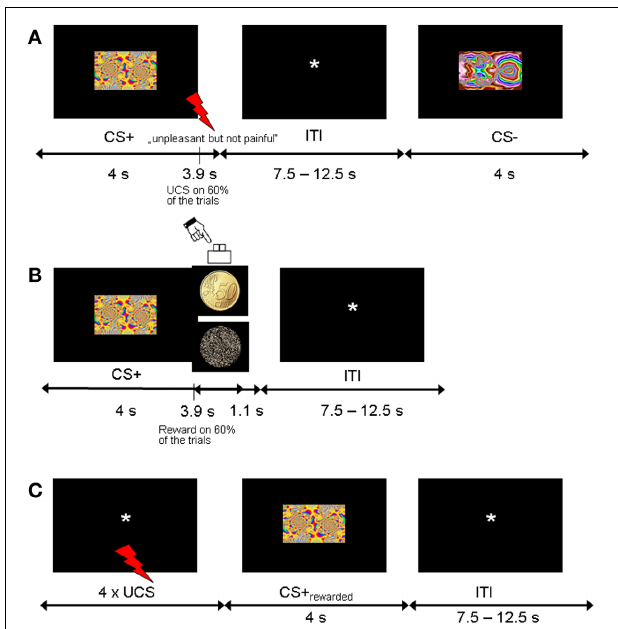
FIGURE 1 | Experimental design. (A) Trial sequence for the fear acquisition phase. CS + were followed by the shock UCS in 60% of trials. (B) Trial sequence for the counterconditioning phase. Half of the CS + and CS − stimuli from the acquisition phase were coupled with monetary reward with 60% contingency, and the other half were never followed by reward. (C) Trial sequence for the reinstatement phase. To test for fear recovery, four UCS were unexpectedly given at the beginning of this phase. None of the CSs were followed by shock or